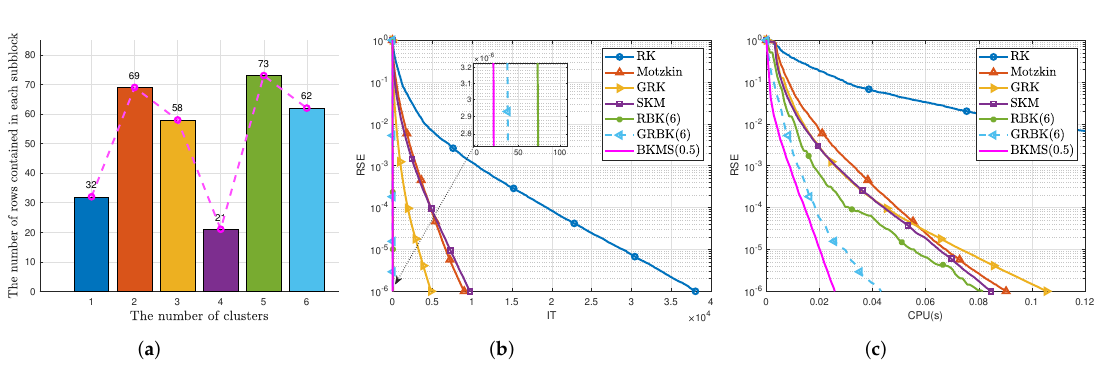
Figure 3. ( a ) The number of rows contained in each partition in BKMS with δ = 0.5. The RSE versus IT ( b ) and RSE versus CPU ( c ) of BKMS compared with other methods for the consistent sparse linear system named